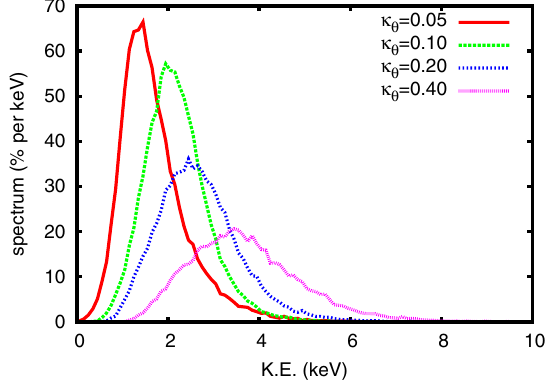
FIG. 9. Antiproton spectrum from RFQ followed by degrader foil and frictional cooling section for various values of (cid:10) (cid:9) .